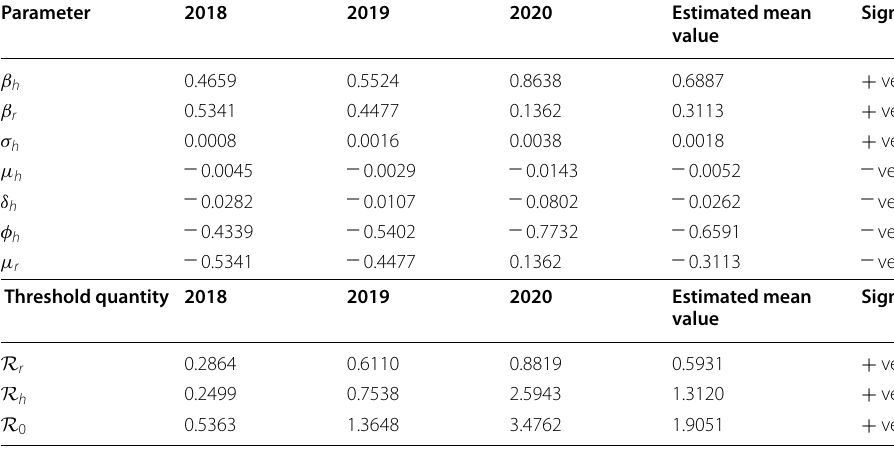
Table 3 Sensitivity indices of the reproduction number parameters